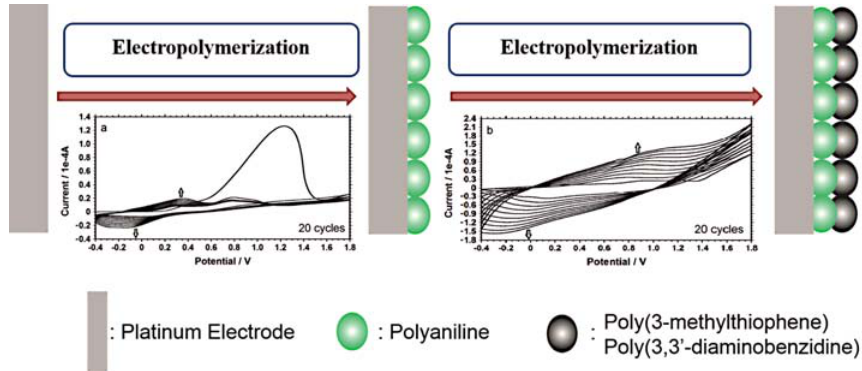
Figure 1. Voltammogram of the deposition and schematic representation of PANI – P3MT- PDAB film a) PANI film on Pt disc electrode b) P3MT – PDAB film deposited on PANI